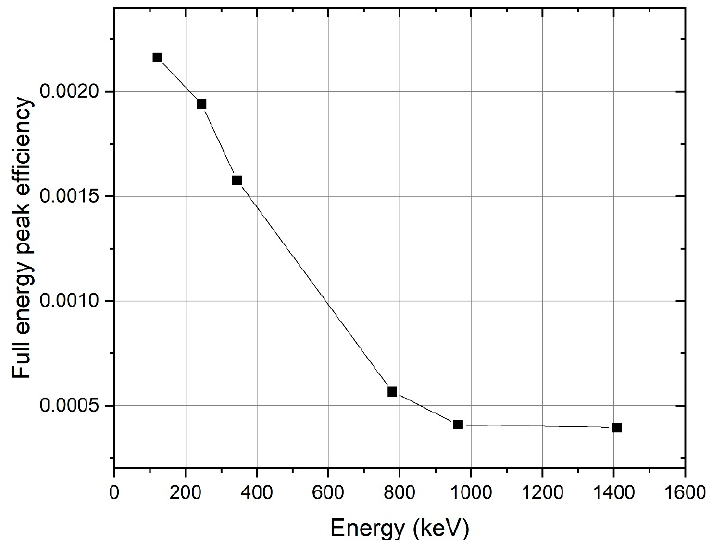
Figure 8. Full energy peak efficiency experimentally determined with a Eu-152 point source posi- tioned 50 cm under the detector.